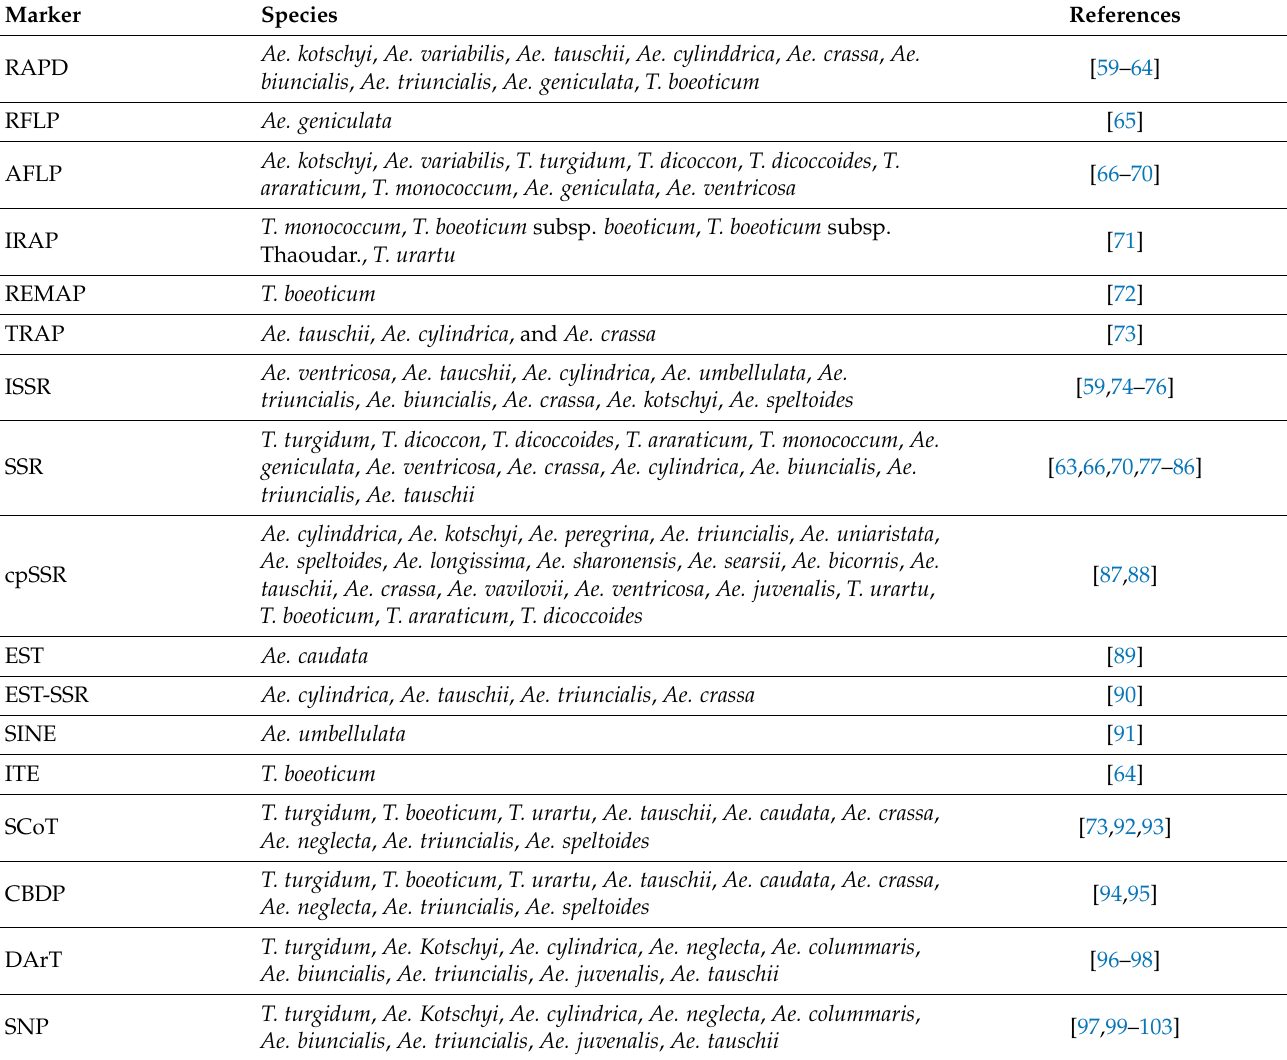
Table 4. List of several studies that reveal a high level of molecular diversity in wild relatives of wheat. Marker